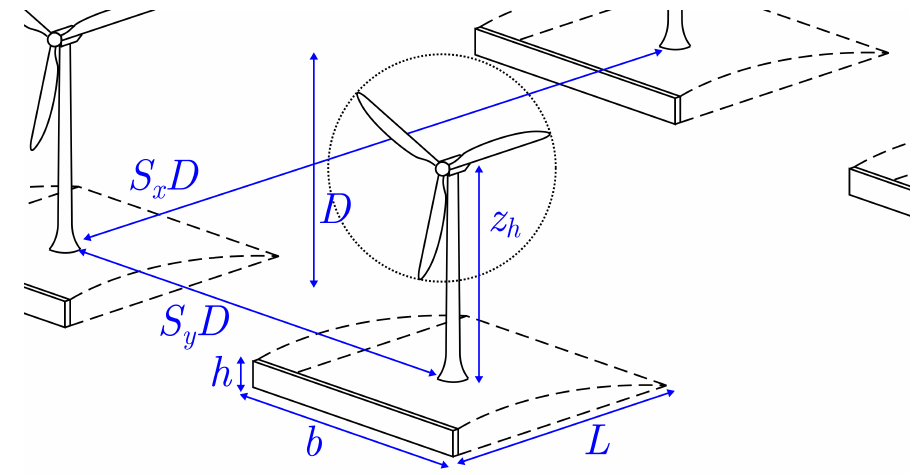
Figure 1. Conceptual schematic of the layout of an infinite wind farm with windbreaks. Dashed lines show the region with reversed